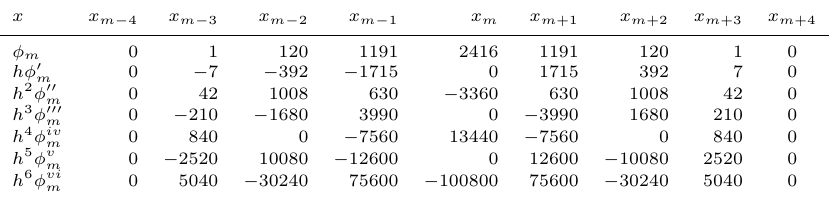
Table 1. Septic B-spline function and its derivatives at nodes x m .